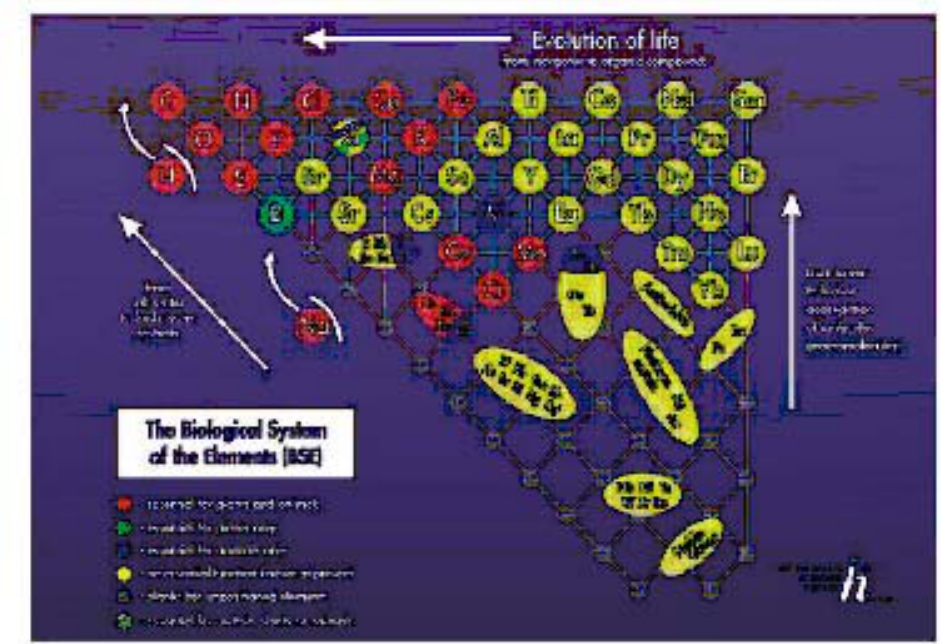
FIGURE 1. The Biological System of the